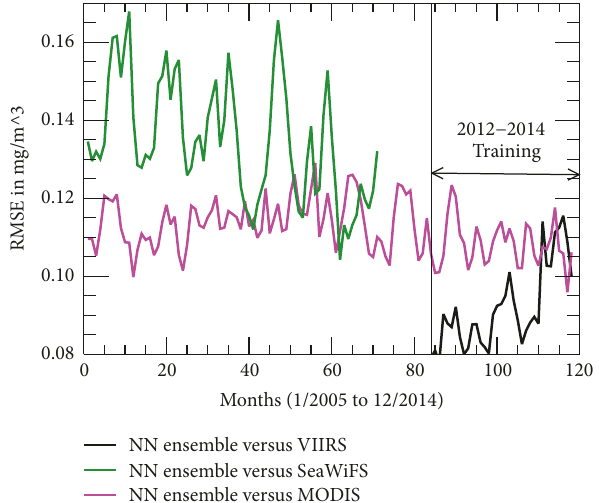
Figure7:RMSEofmonthlymeanchl-aconcentrationssimulatedby NN ensemble versus VIIRS data (black curve), MODIS data (pink curve), and SeaWiFS data (green curve).